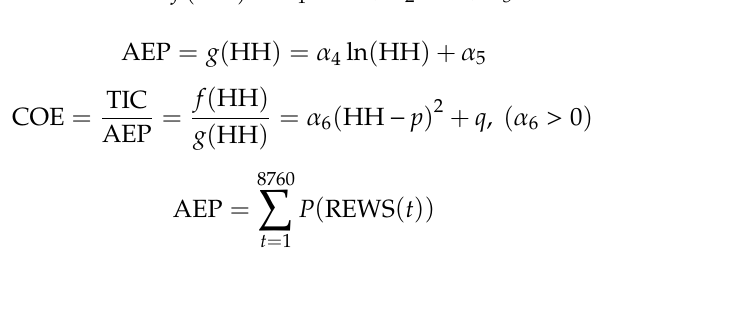
Figure 3. Rotor area fraction and corresponding weights for rotor equivalent wind speed (REWS) calculation.